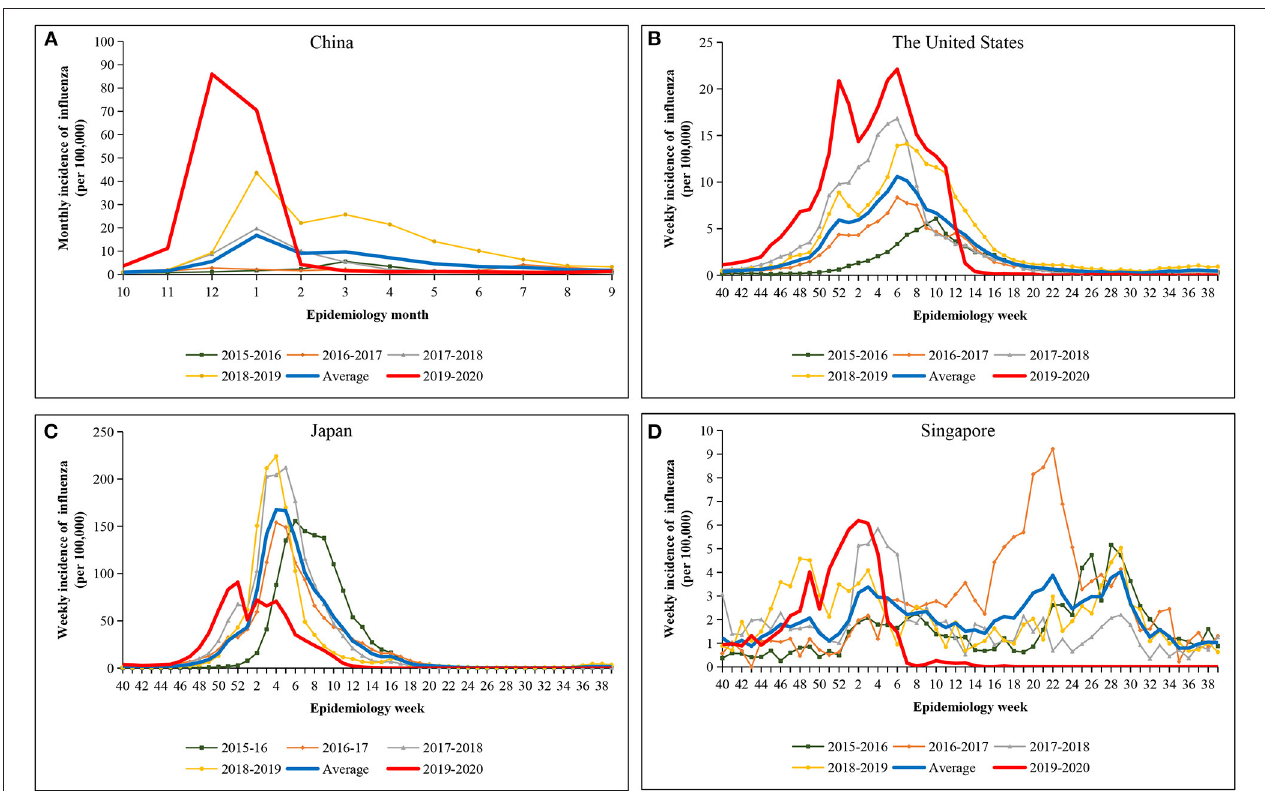
FIGURE 1 | Non-pharmaceutical interventions across the four countries during the COVID-19 outbreak, and the observed (red line) and average (blue line) epidemic curve of influenza. (A) China. (B) The United States. (C) Japan. (D)